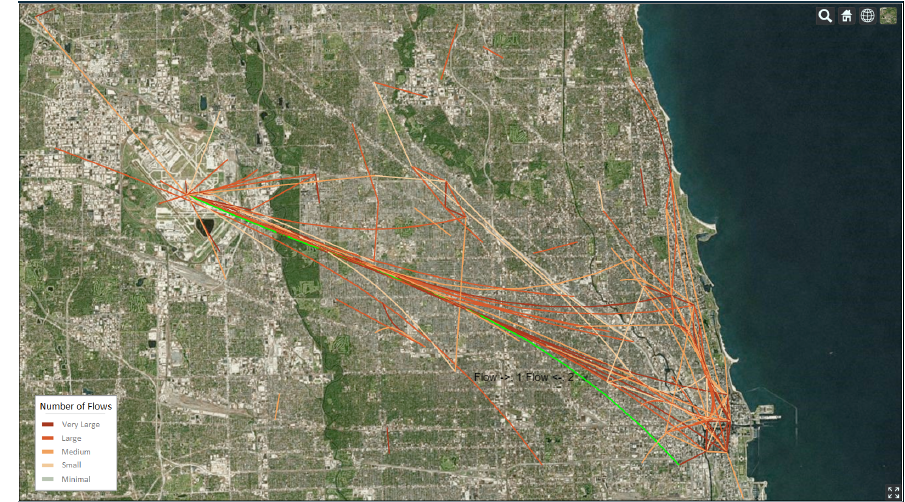
Figure 10. The top 20% movement flows between O’Hare International Airport and the city center of Chicago